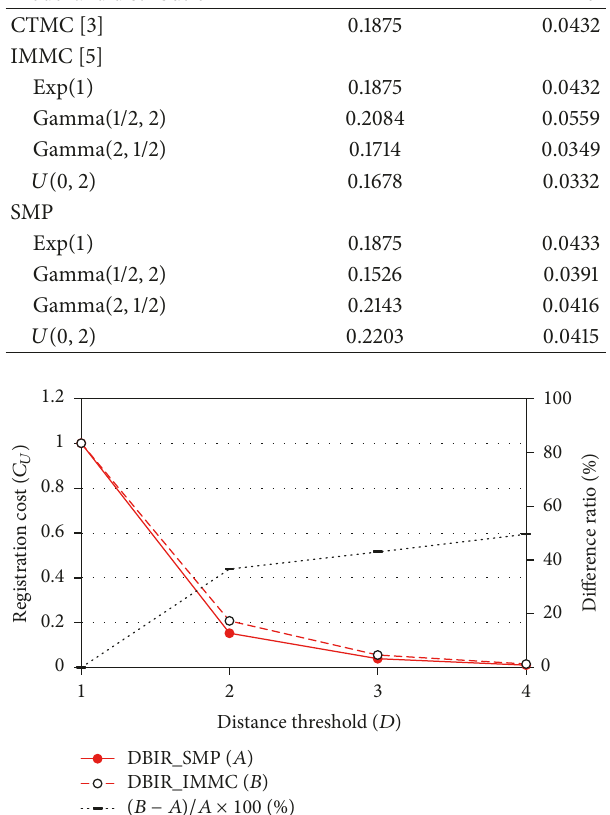
Table 1: Registration cost for various cell sojourn time distributions. Model and distribution